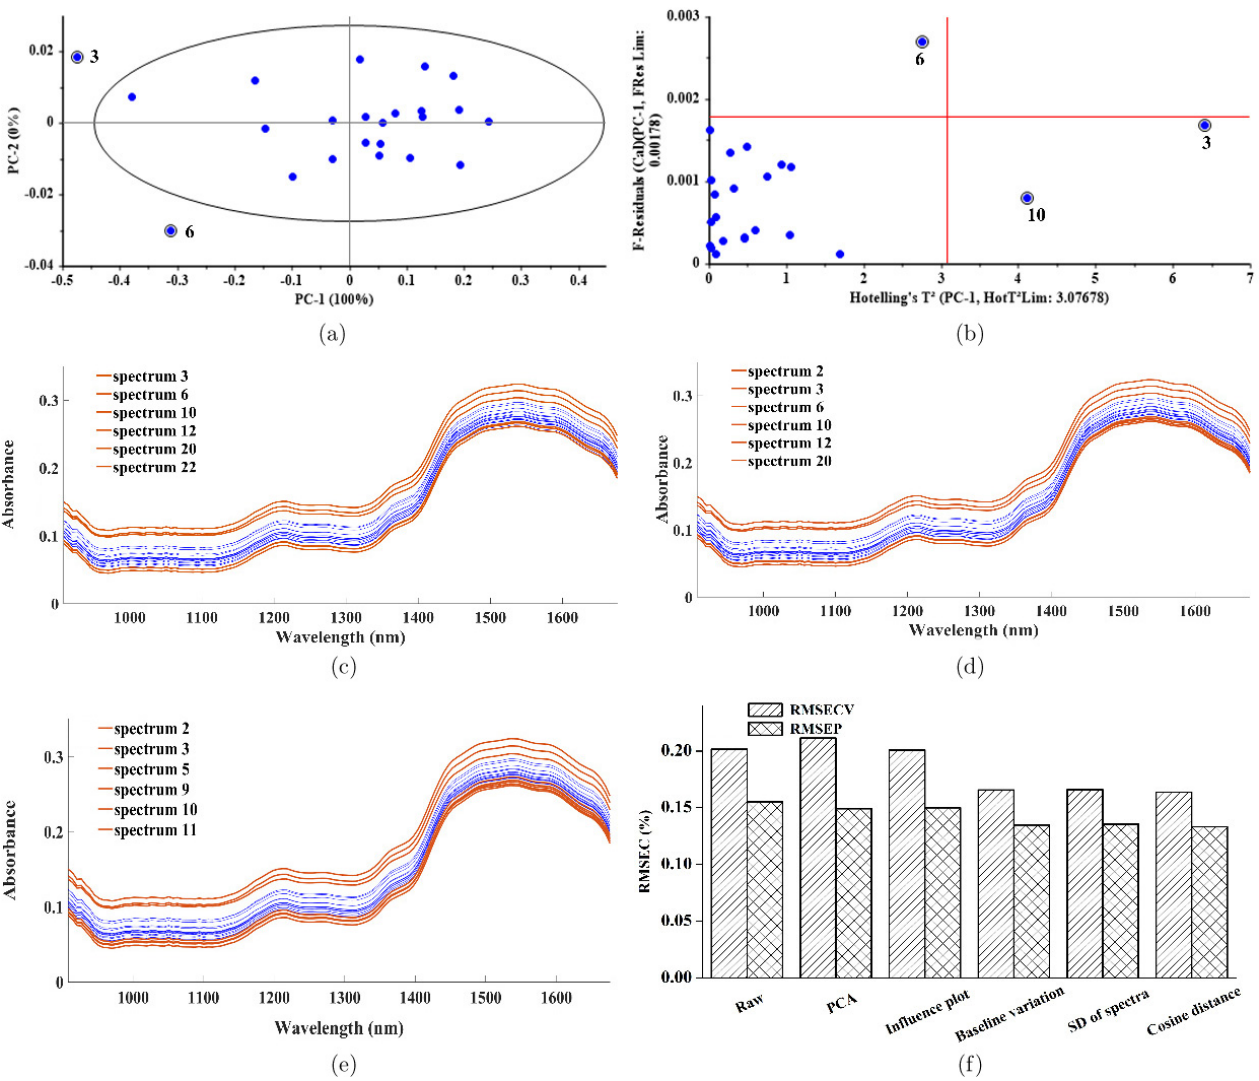
Fig. 3. (a) – (e) Results of di®erent spectral selection methods for the sampling point corresponding to 10 min in the granulation process (f) RMSEP values of NIR models with di®erent spectral selection methods.